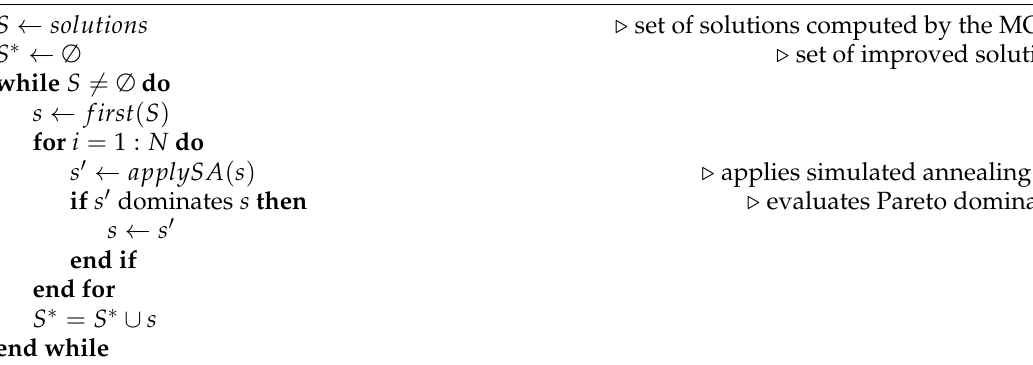
Algorithm 3 Schema for post hoc optimization using Simulated Annealing